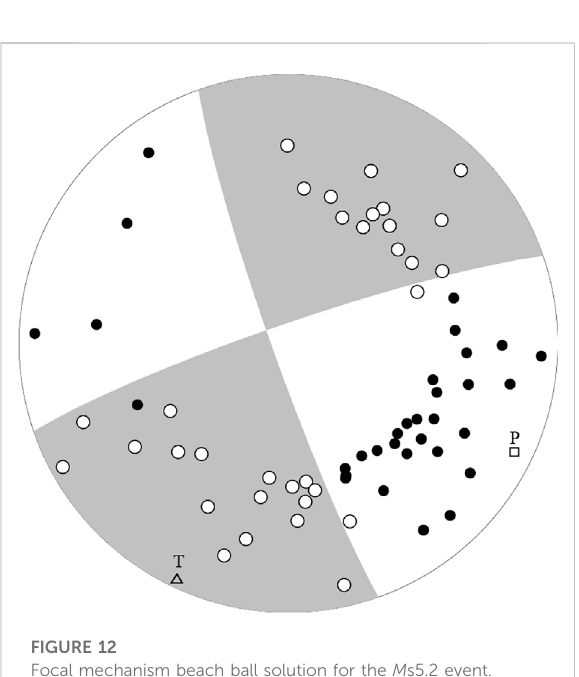
FIGURE 12 Focal mechanism beach ball solution for the M s5.2 event. Solid and hollow circles indicate downward and upward polarities,